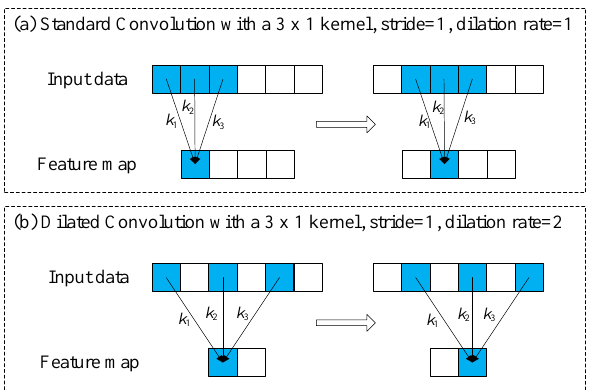
Figure 1. Comparison of standard convolution and dilated convolution.